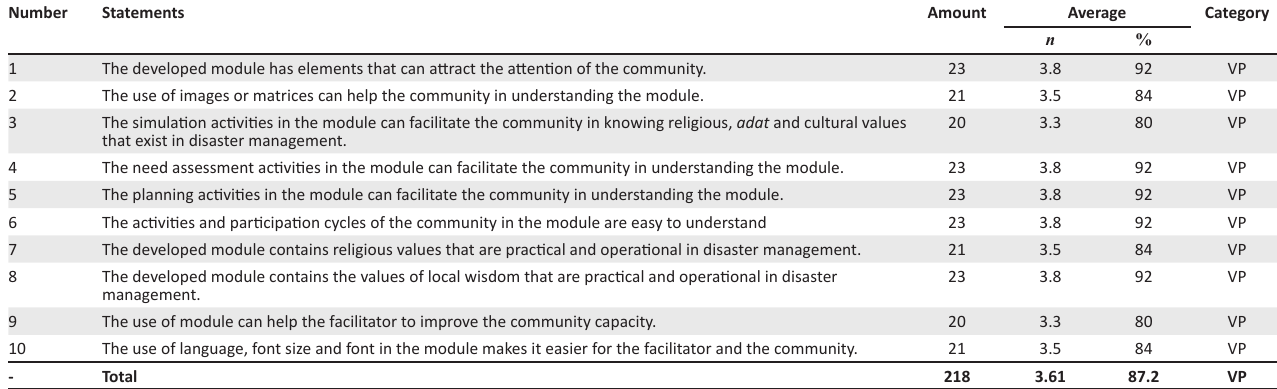
TABLE 2: The results of practicality test on local wisdom-based disaster